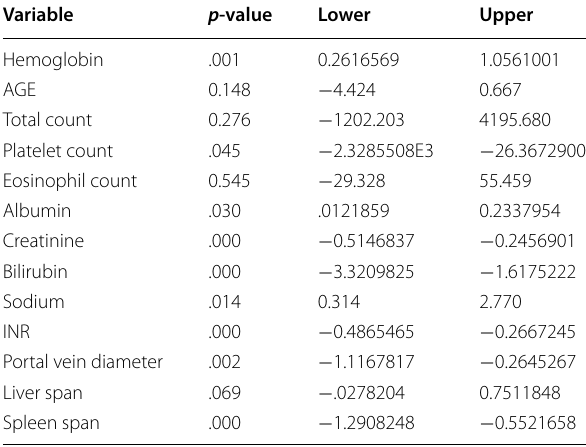
Table 2 Baseline characteristics of test and validation cohort Table 3 Quantitative baseline variables in predicting 3-month Test cohort Validation cohort